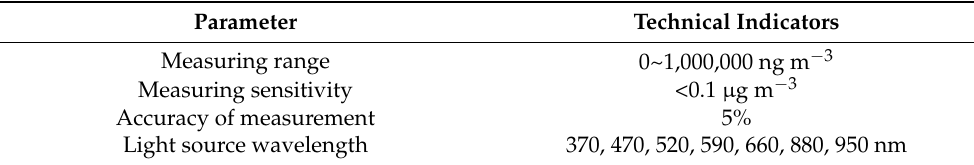
Table A1. Main technical parameters.